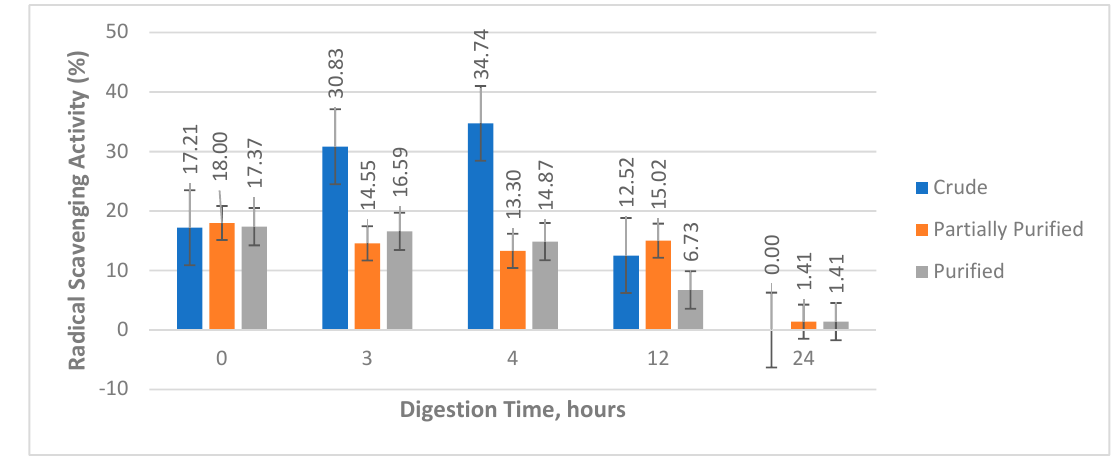
Figure 5. Comparison of DPPH radical scavenging activity (RSA) of crude, partially purified and purified protein extracts at different digestion hours. (Note: DPPH RSA of crude at 24 h digestion time is not included due to highly negative value obtained, − 107.355%).